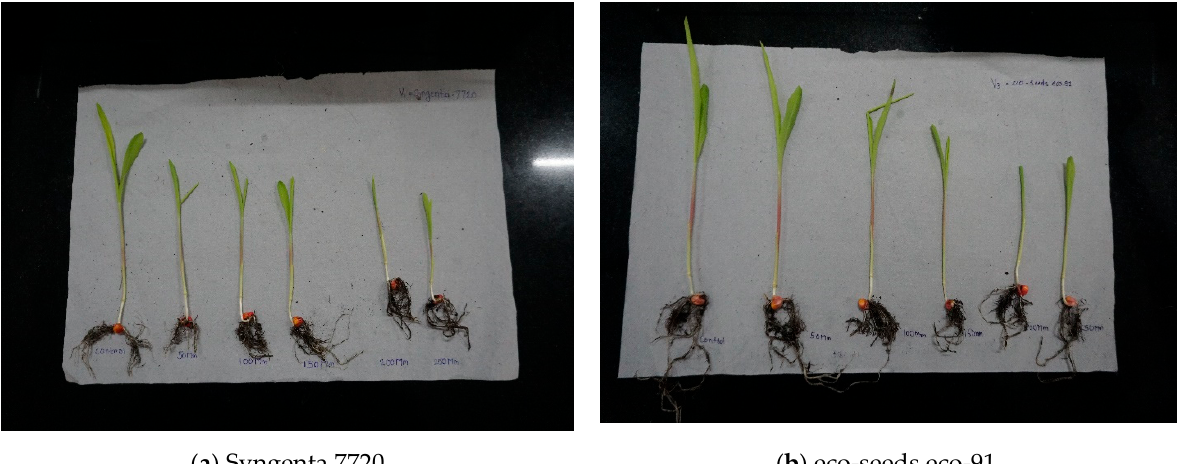
Figure 1. Varieties that have significant increase in